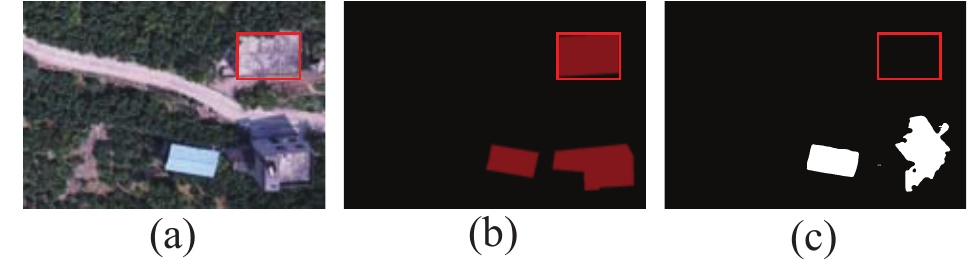
Figure 11. Comparison of pseudo-labels. Red boxes represent regions of under-activation: ( a ) image; ( b ) ground truth; and ( c )